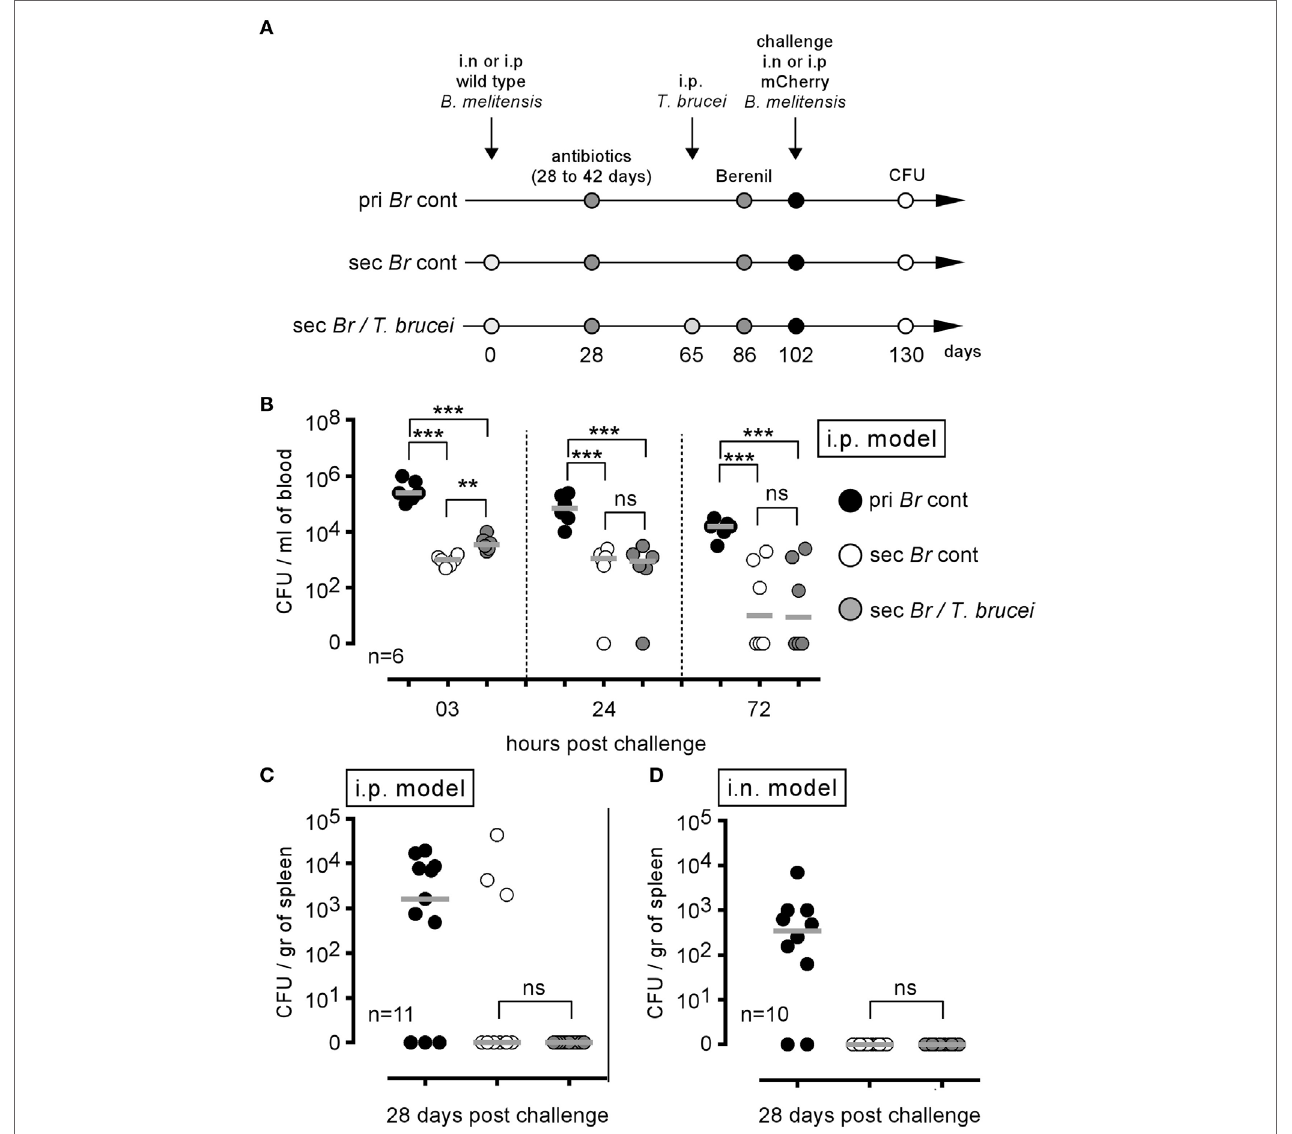
FigUre 8 | Trypanosoma brucei co-infection did not affect the protective memory against Brucella melitensis . As described in panel (a) , wild-type C57BL/6 mice were infected i.p. or i.n. with 2 × 10 4 CFU of wild-type B. melitensis and treated with antibiotic at 28 days postinfection for 15 days. At 65 days, the mice received an i.p. injection of 5,000 T. brucei in 200 µl of PBS (Sec Br / T. brucei group) or PBS alone (Sec Br cont group) were treated with Berenil at 86 days and were challenged at 102 days with i.p. or i.n. injection of 2 × 10 4 CFU of mCherry- B. melitensis . The pri Br cont group received only PBS, antibiotic, and Berenil until the Brucella challenge. (B,c) i.p. model: the data represent the number of colony-forming units per milliliter of blood or colony-forming units per gram of spleen at the selected time post challenge, as indicated. (D) i.n. model: the data represent the number of colony-forming units per gram of spleen. Gray bars represent the median. n denotes the number of mice used for each group (** p < 0.01, *** p < 0.001). These results are representative of at least two independent